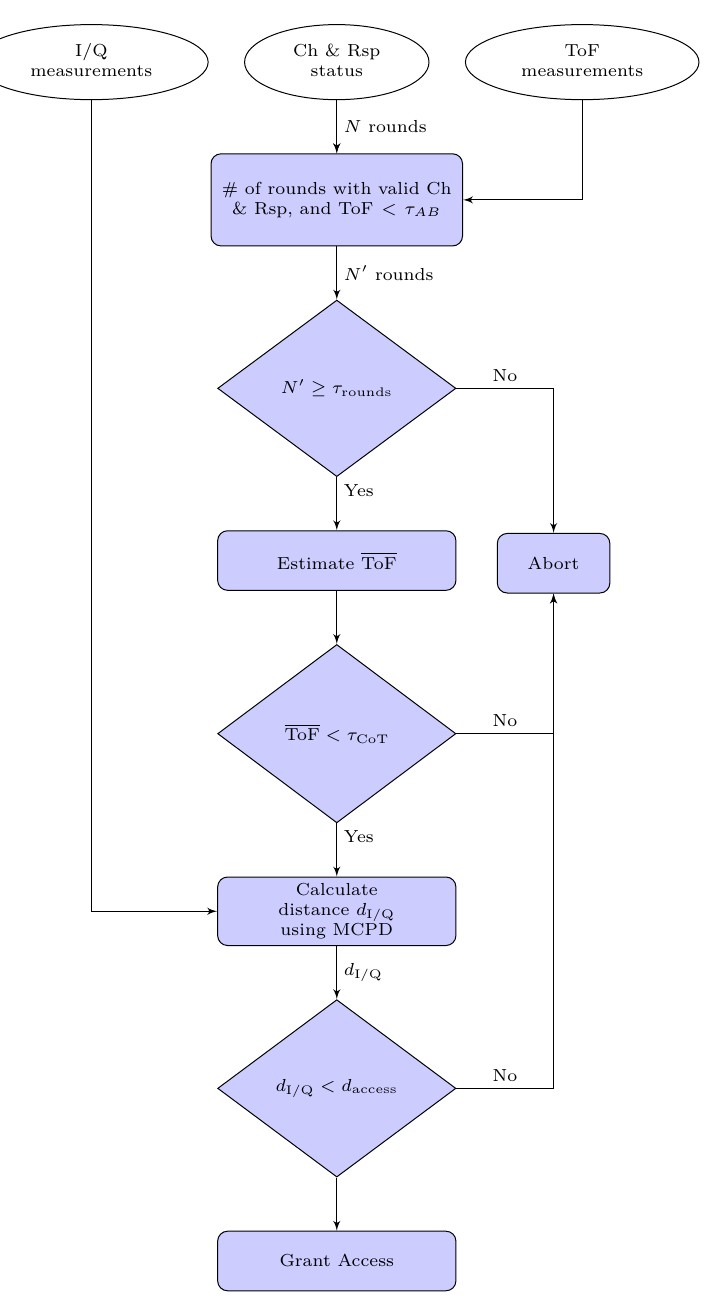
Figure 5: Schematics of our proposed decision